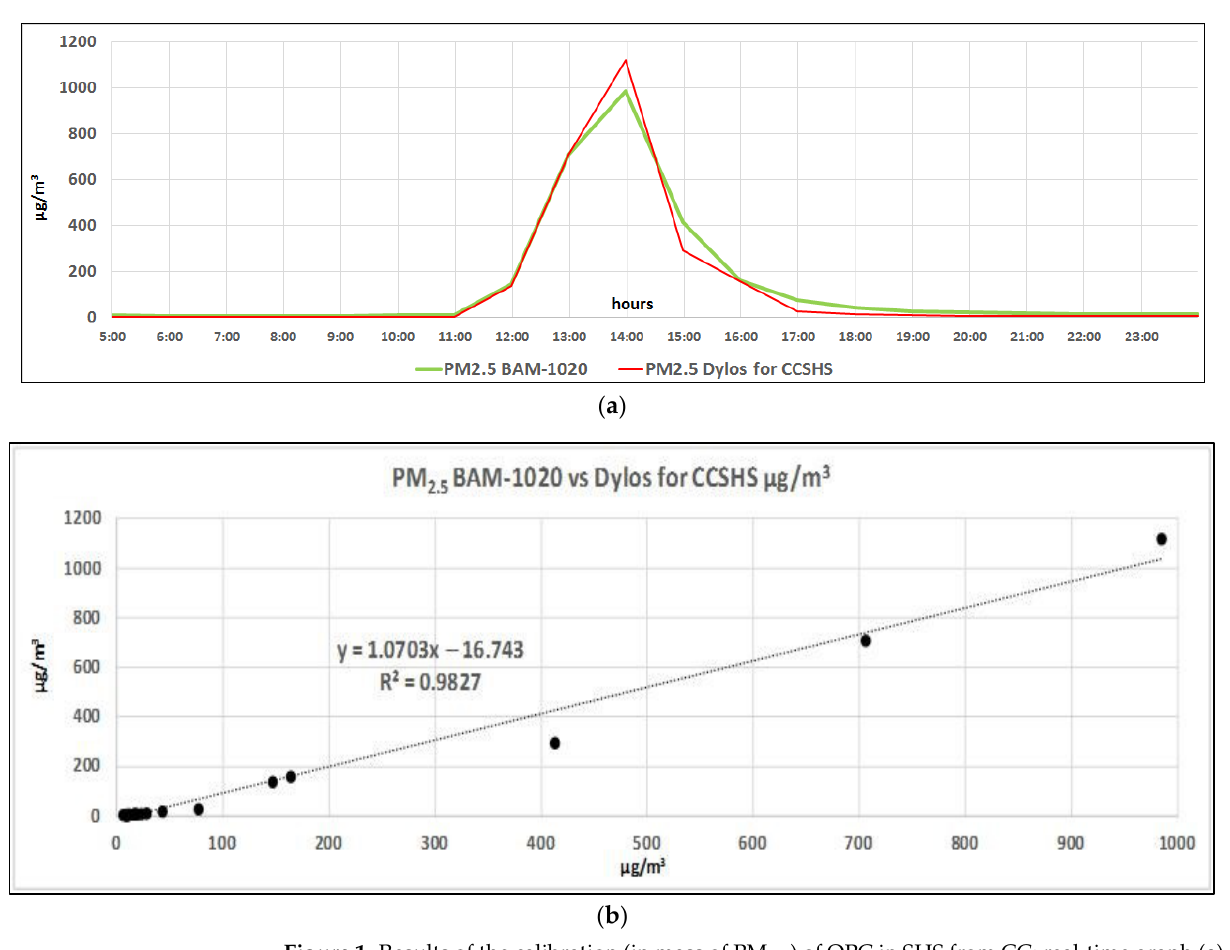
Figure 1. Results of the calibration (in mass of PM 2.5 ) of OPC in SHS from CC: real-time graph ( a ) and linear regression analysis ( b ).